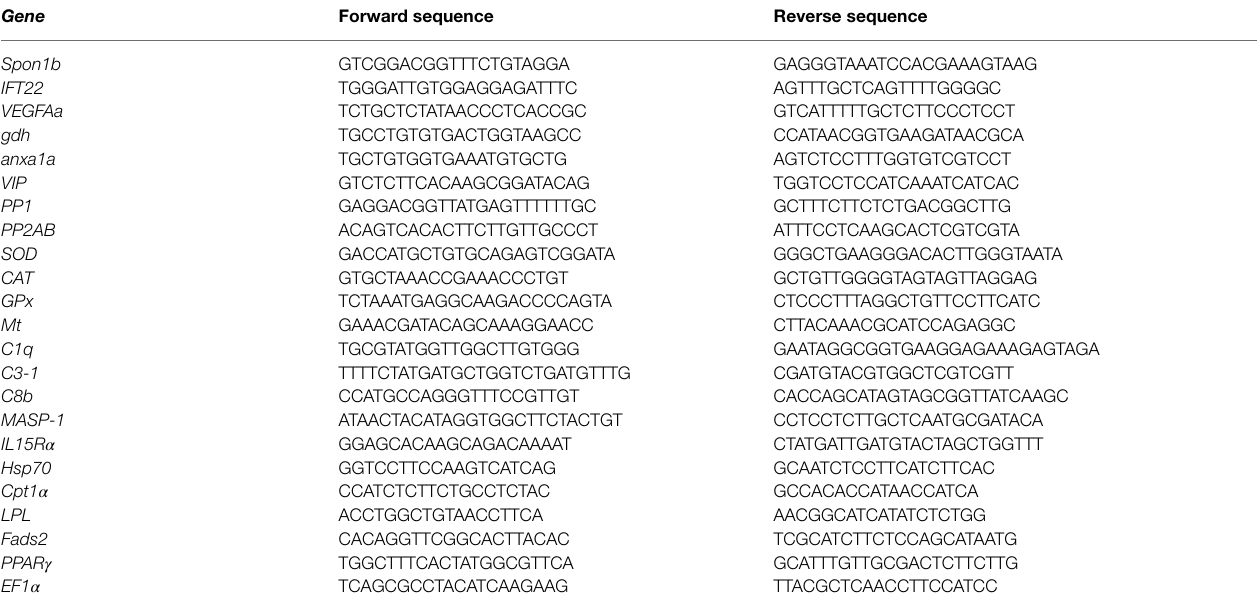
TABLE 1 | Primers used in the present